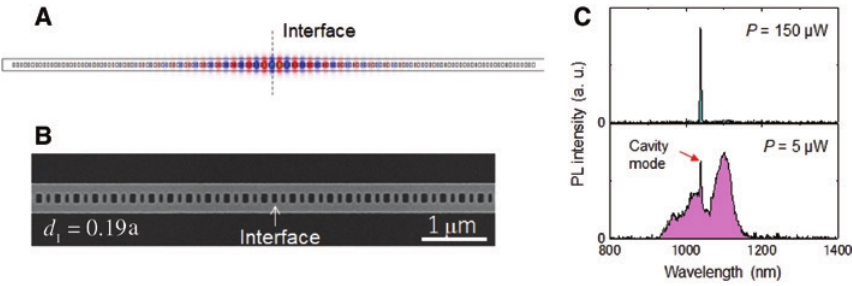
Figure 5: Lasing from a topological nanocavity laser. (A) Calculated electric field distribution for the topological nanocavity designed with d localized in the vicinity of the interface. (B) Scanning electron microscope image of the fabricated structure. The position of the interface is indicated by an arrow. (C) Emission spectra measured under optical pumping. Bottom: a spectrum taken with a low pump power. Top: a lasing spectrum measured with a high pump power. Clear single-mode lasing can be confirmed by the single cavity peak dominating the spectrum. Reproduced from Ref.